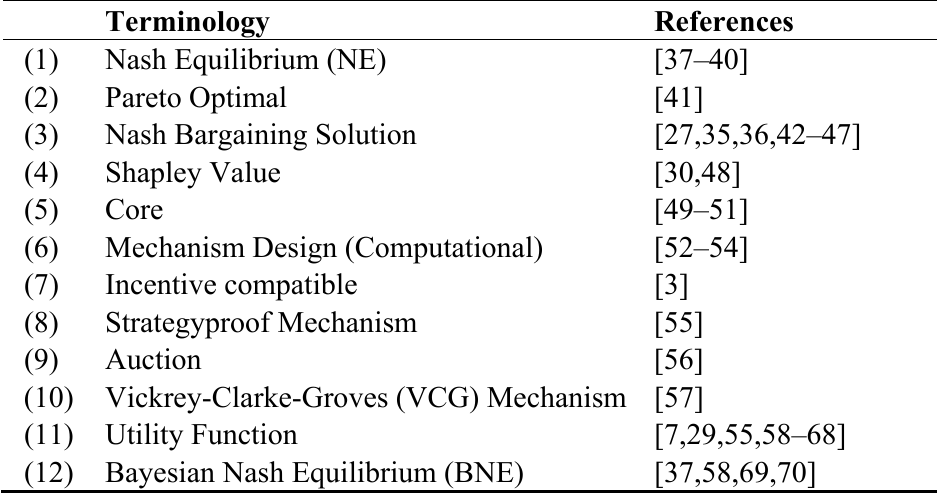
Table 2. Common Terminologies in